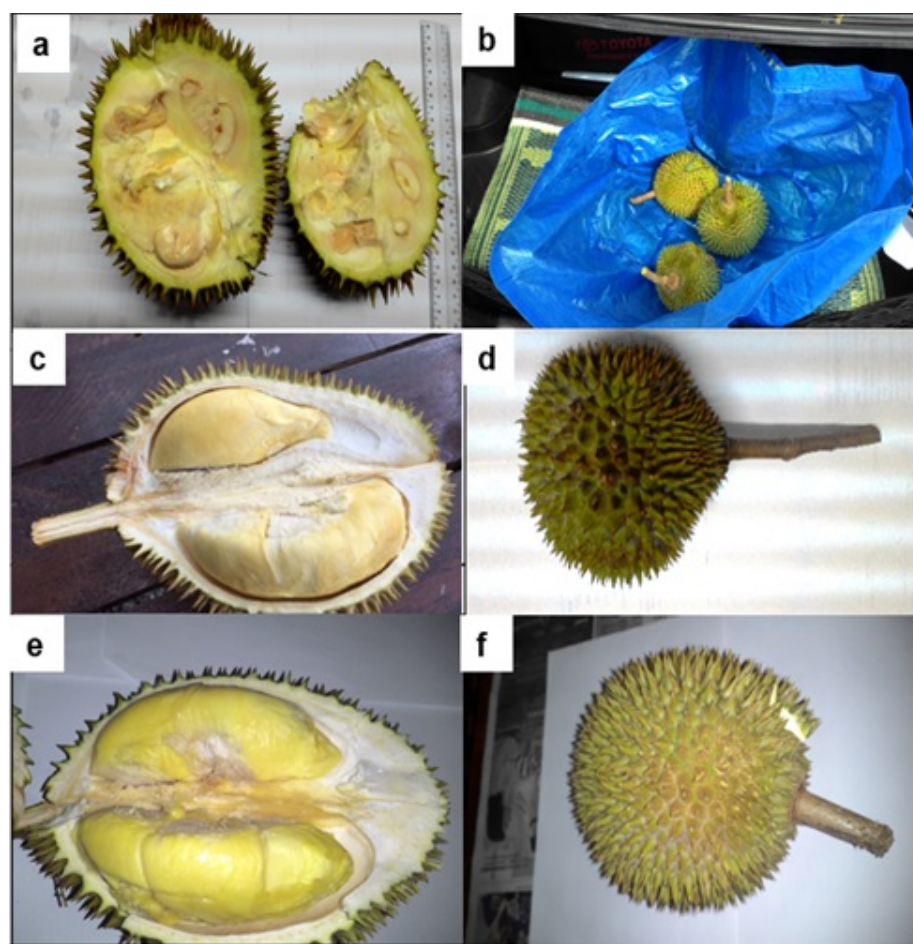
Figure 1 − Durian fruits and pulp tissue. (a-b) Durian fruits at its young stage of growth and development (90 days); (c-d) Durian fruit at its mature stage of growth and development (120 days); and (e-f) Durian fruit at its ripening stage of growth and development (127